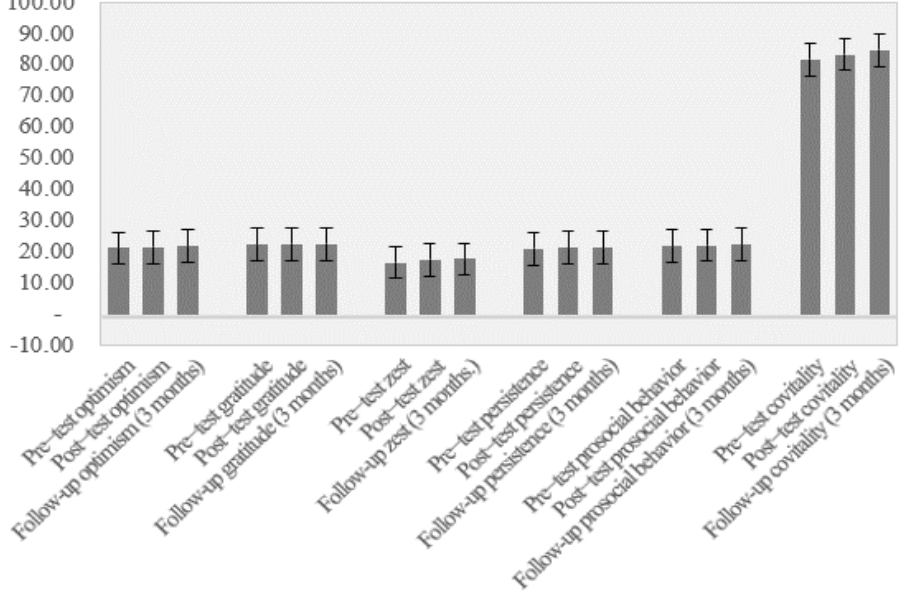
Figure 3. Mean scores for the subscales of the Spanish version of the Social-Emotional Health Survey-Primary-Revised for pre-test, post-test, and the 3-month follow-up.